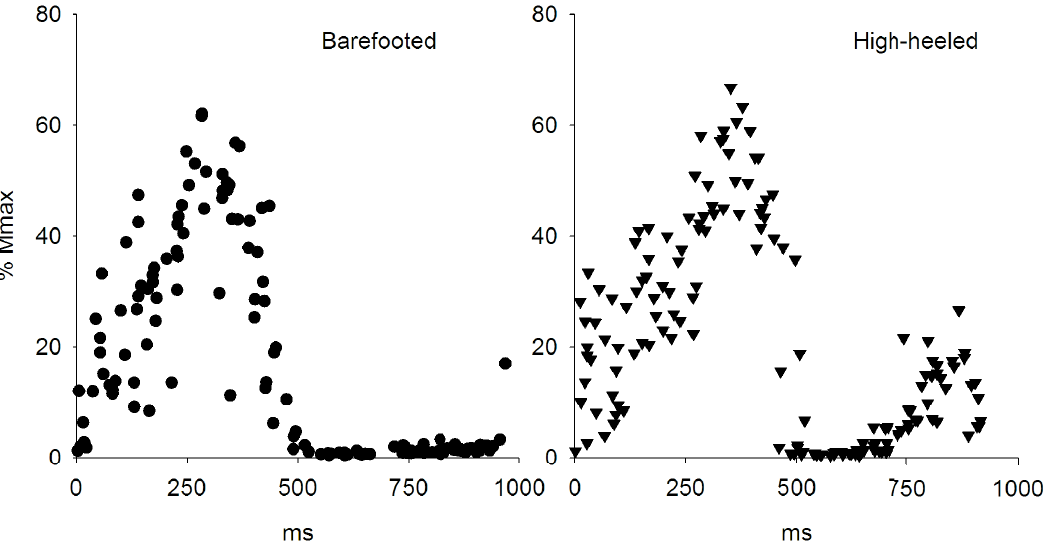
Figure 2. Recordings of SO H-reflex from one subject. Data recordings of SO H-reflex (% Mmax) from one subject during barefooted (dots) and high-heeled (triangles) walking. The stimuli to elicit the H-reflexes were given every 2 s corresponded to 25% ( 6 10%) of the resting Mmax and were slightly out of phase with the gait cycle, which ensured the stimuli to be dispersed randomly over the gait cycle (see text for further explanations).